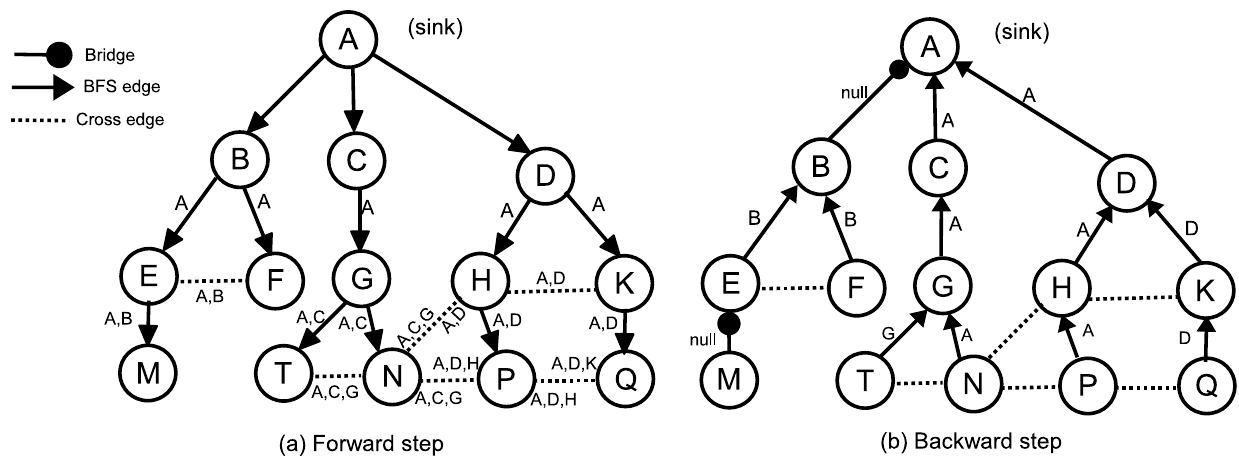
Figure 4. Transmitted messages in ancestral knowledge-based bridge detection algorithm (ABIDE)